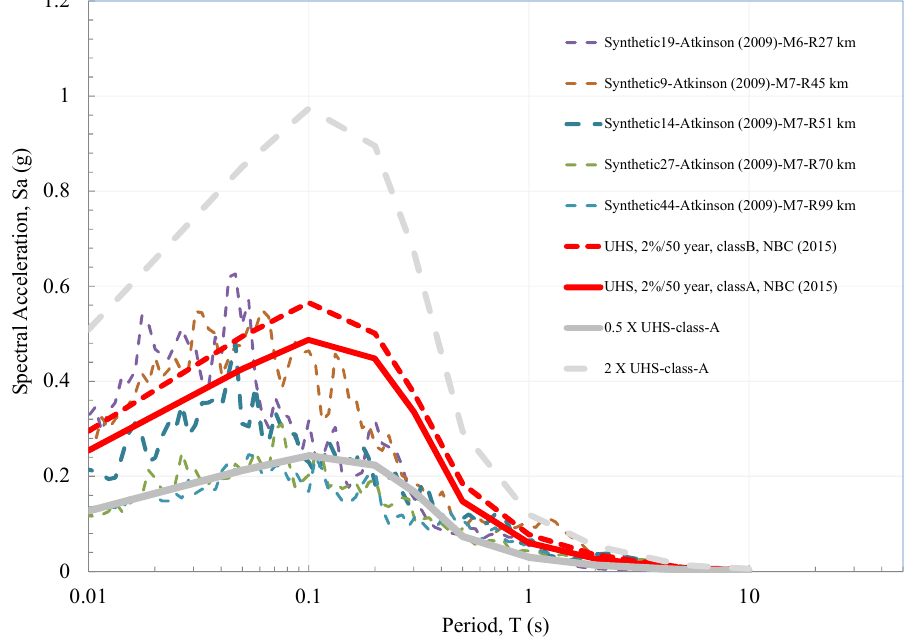
Figure 2. Response spectra (damping ratio of 5%) of synthetic accelerograms for hard rock site condition proposed in [33] and UHS for site classes A and B (NBCC 2015).